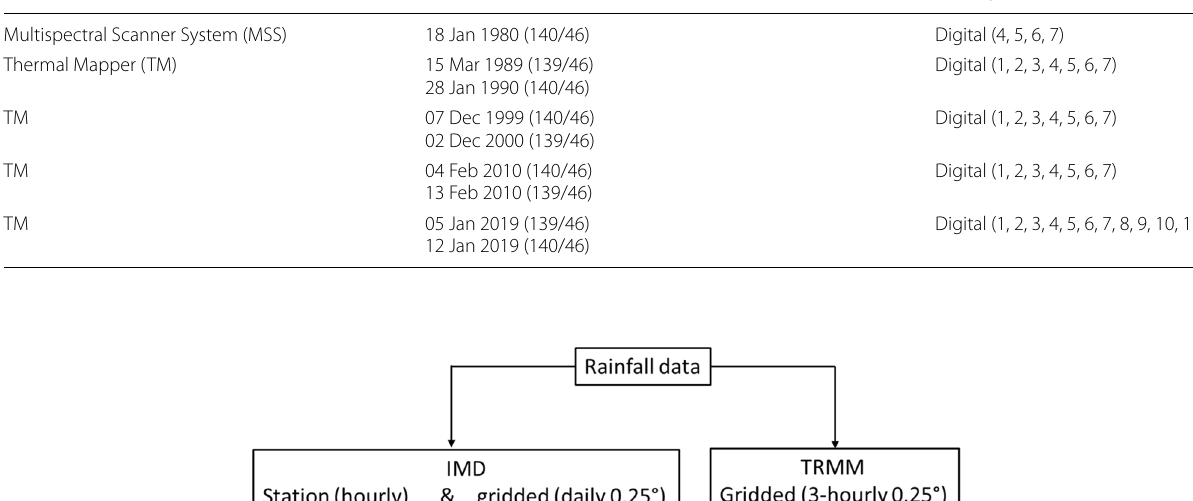
Table 1 Details of Landsat Satellite data processed for the urban land use/cover analysis Sensor Date of acquisition (Path/Row)